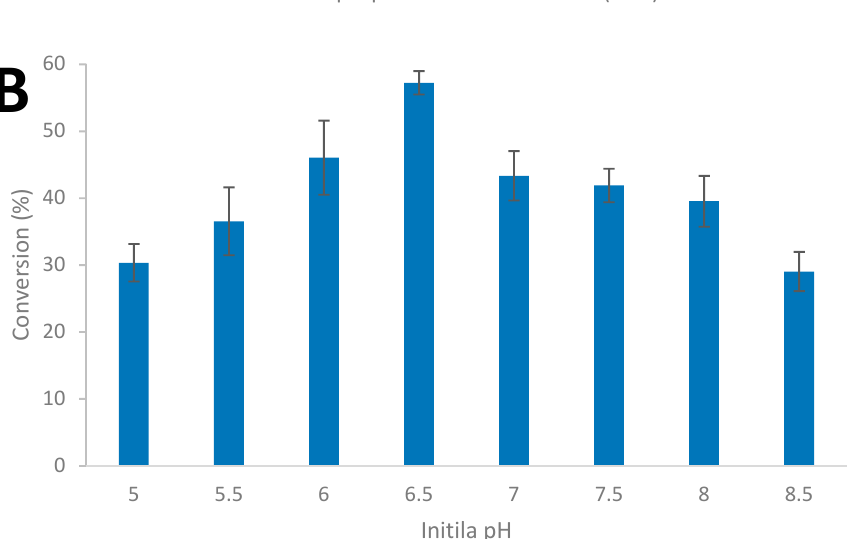
Figure 5. Influence of initial propionate concentration at 65 ◦ C and pH 7.0; ( A ) and initial pH with 20 mM propionate concentration; ( B ) during glucose (20 mM) fermentation by Thermoanaerobacter strain AK152 (65 ◦ C. Values represent the average of triplicates with standard deviation presented as error bars.